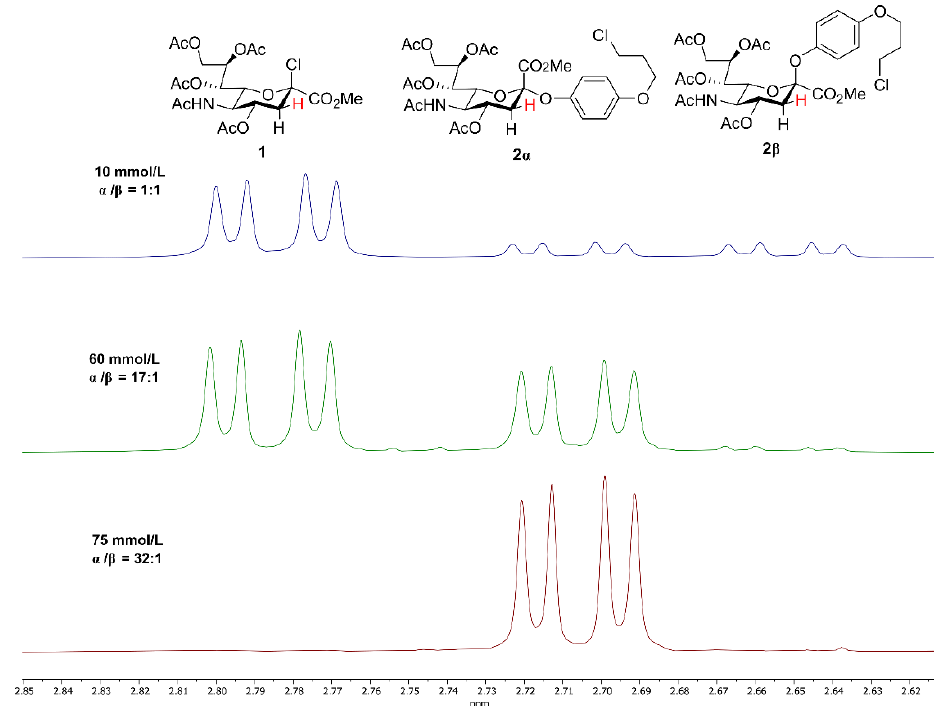
Figure 3. Part of the 1 H NMR spectra (600.13 MHz, CDCl 3 ) of the worked-up reaction mixtures showing H-3eq signals of N -acetylsialyl chloride 1 and α - and β -sialosides 2 α and 2 β : see entry 2 (blue line), entry 7 (green line) and entry 8 (red line) in Table 1.